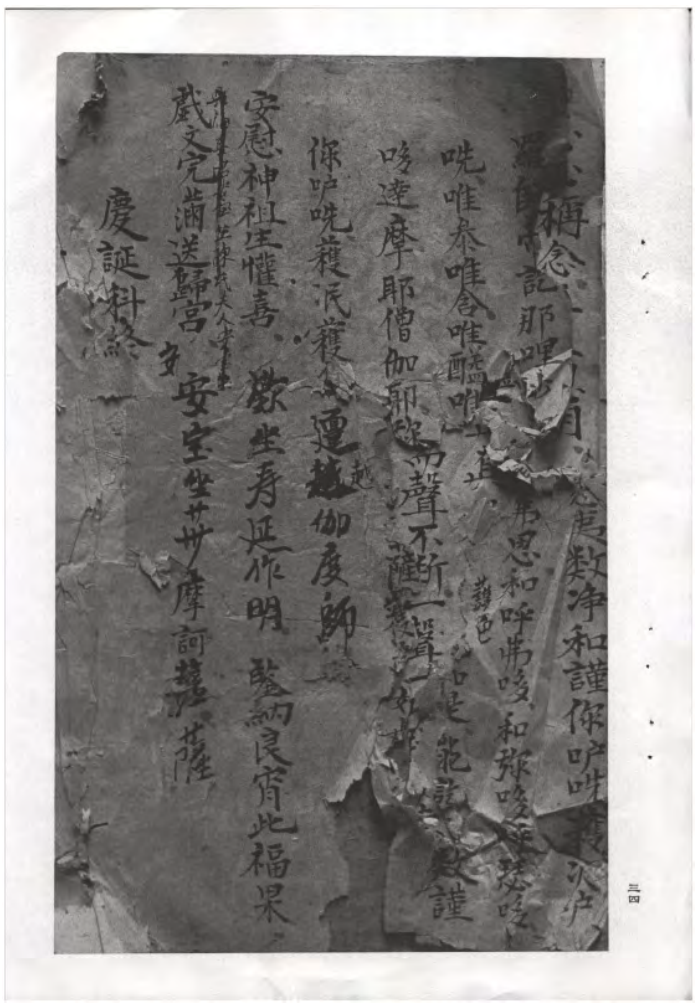
Plate 1: page 34 of Ritual Manual for the Celebration of the Birthday of Ancestor of Promoting Well-being Lines 235-236 tell us that “ shenzu 神祖 holy ancestor” (i.e., 興福祖 ancestor of promoting well-being, i.e., Lin Deng) enjoyed his birthday feast and was sent back to his temple after the performance was over. Note Lushen i.e., 嚧詵 which we can write as 嚧詵 now,